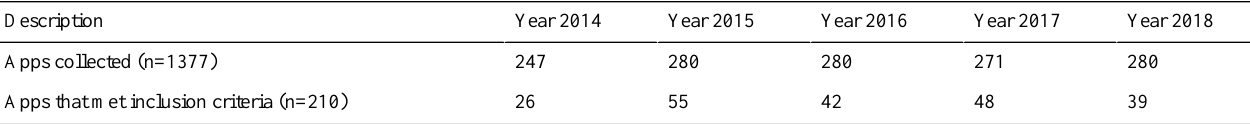
Year 2018Year 2017Year 2016Year 2015Year 2014Description